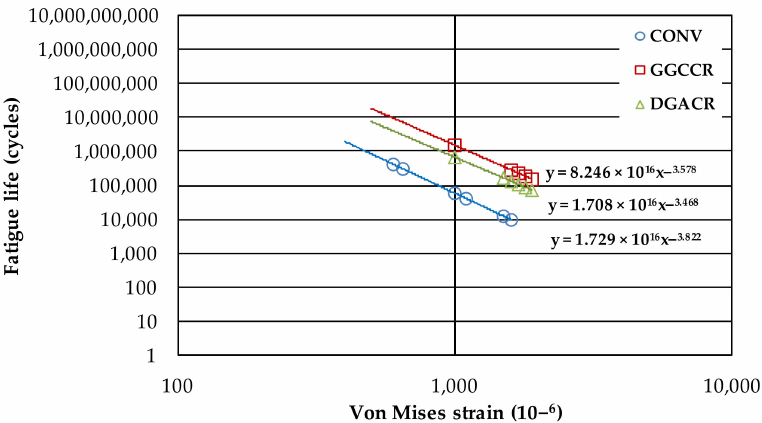
Figure 13. Reflective cracking fatigue